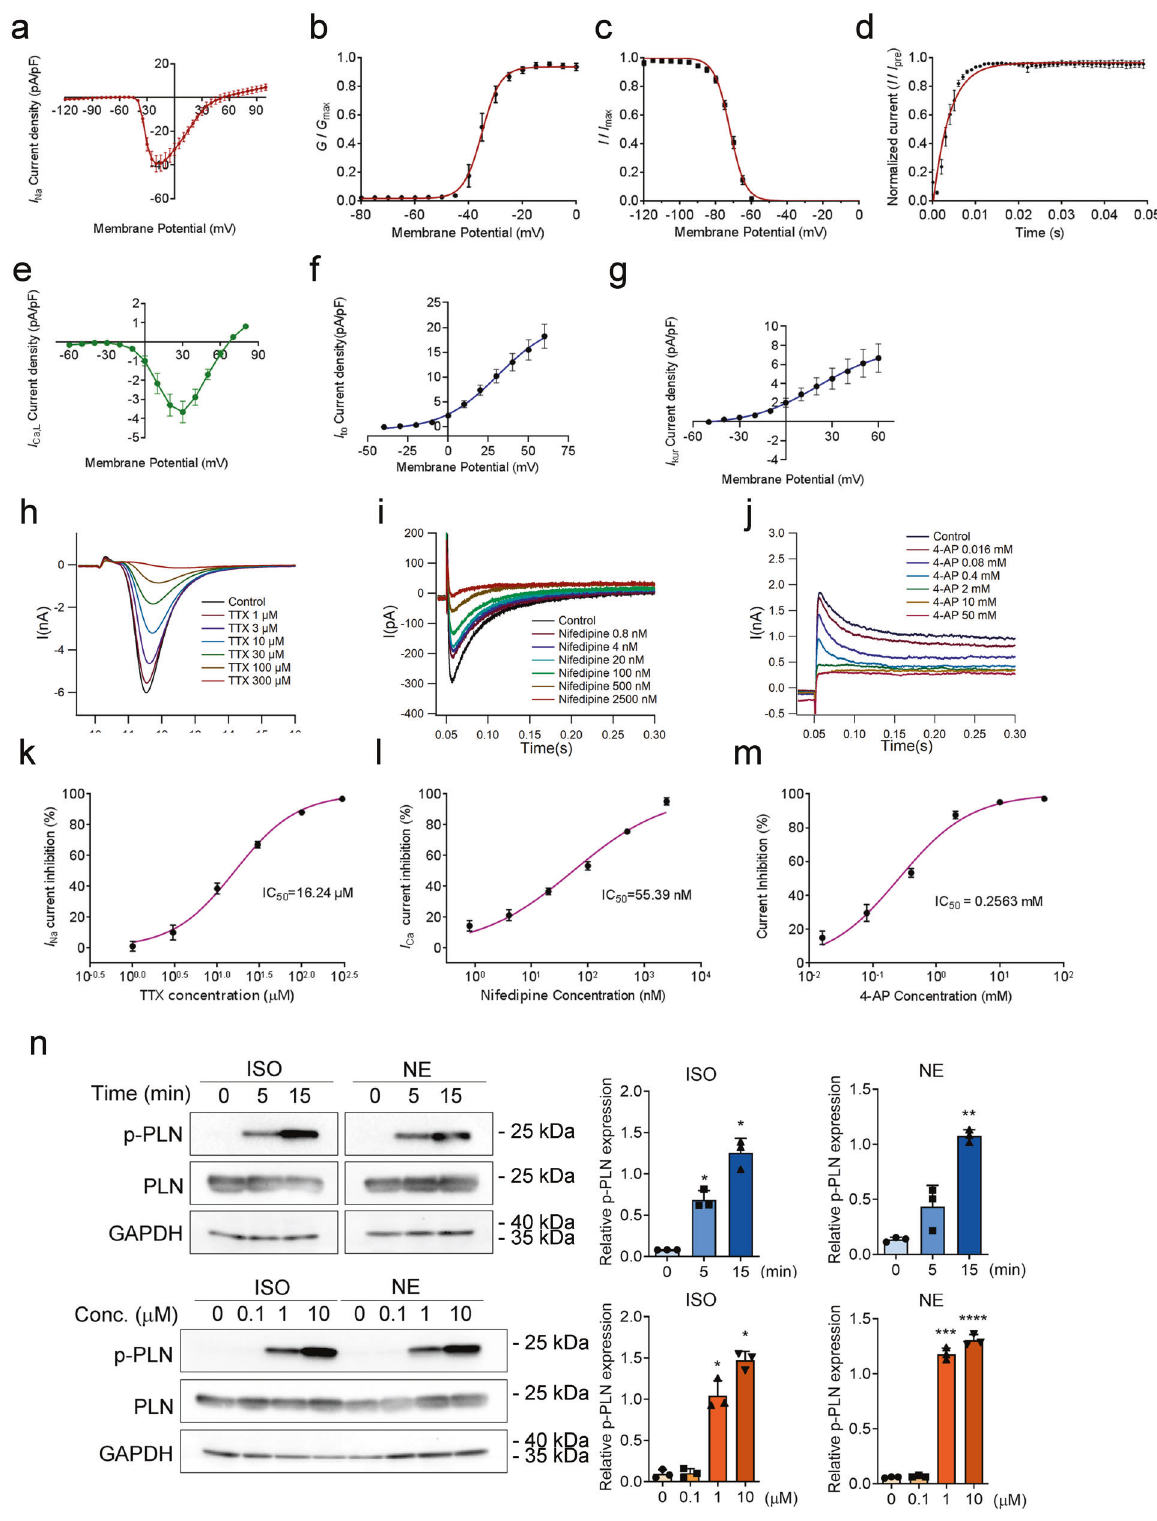
Fig. 2 Functional integrity of freshly isolated hPCMs. a – d Voltage-dependent kinetics of sodium currents. Current – voltage (I – V) relation curve ( a ), Voltage-dependent activation ( b ), inactivation ( c ), and recovery ( d ) curves of I Na ( n = 10). e – g I – V relationships for I Ca, L ( n = 4) ( e ), I to ( n = 7) ( f ), and I kur ( n = 8) ( g ). h – m Dose-dependent current inhibition of I Na ( h , k ), I Ca, L ( i , l ), and I to ( j , m ). Data were mean ± SEM. n Phosphorylation of phospholamban (PLN) in response to isoproterenol (ISO) and norepinephrine (NE) in a time- and dose-dependent manner (upper and lower panels, respectively) in hPCMs. GAPDH was used as a loading control. For time dependency experiments, stimulants were used at a concentration of 10 μ M, while for the dose-dependency experiment, agonists were applied for 45 min. The blots shown are representative of three independent experiments. Quanti fi cations of blots are shown on the right. Data were mean ± SD, one-way repeated measures ANOVA. * P < 0.05, ** P < 0.005, *** P < 0.0005, **** P < 0.0001 Signal Transduction and Targeted Therapy (2022)